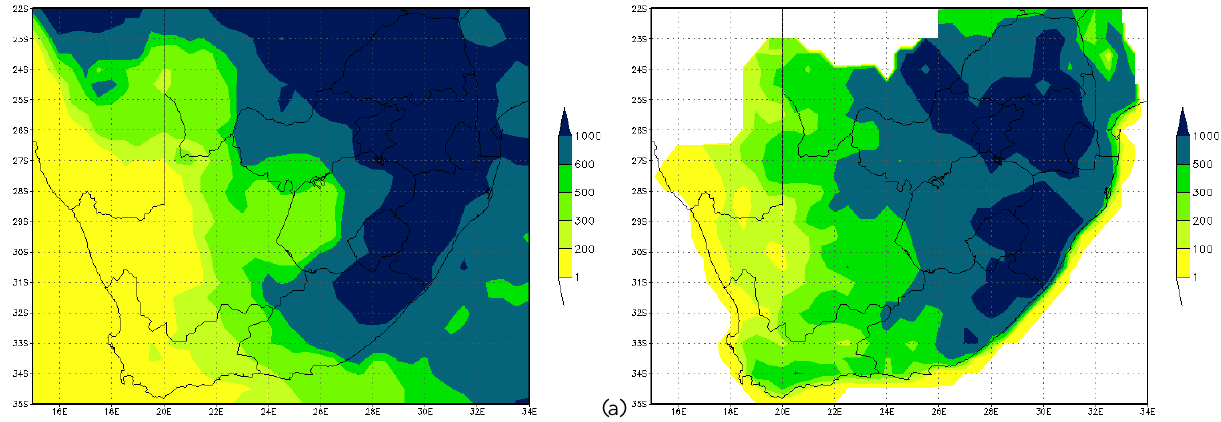
Fig. 6. HE summer rainfall for 2008 and 2009 (a) and rainfall measured by the gauges in the summer of 2008 and 2009 (b) .